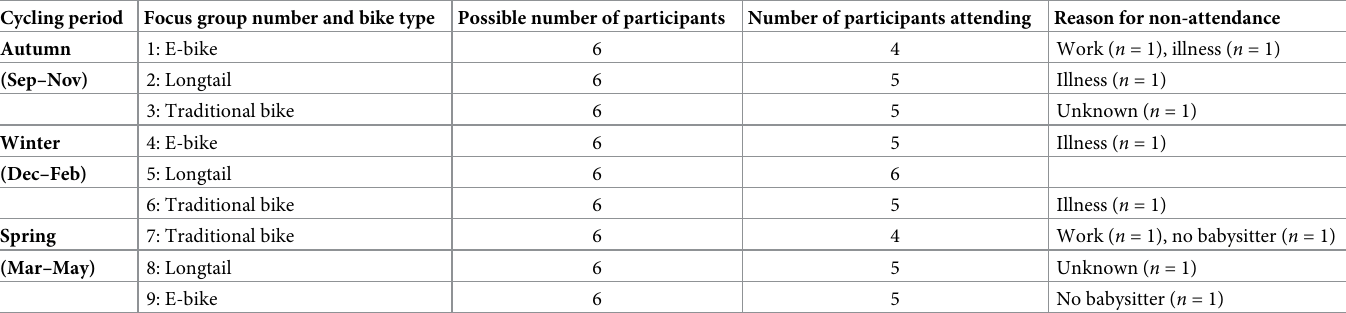
Table 1. Participation in the nine focus group